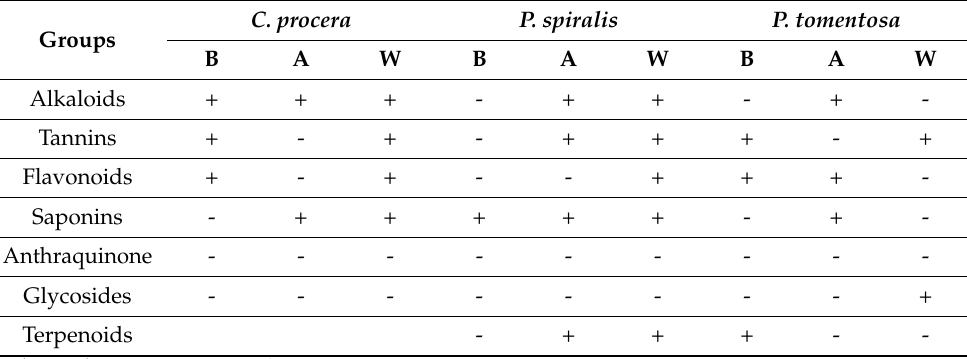
Table 1. Major phytochemical groups detected in crude extract fractions of C. procera , P. spiralis and